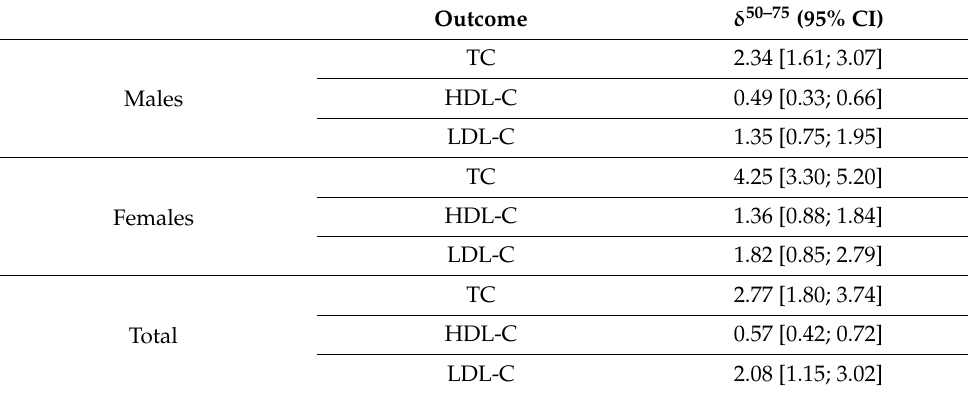
Table 4. BKMR estimates * and 95% confidence intervals for the change in TC, HDL-C and LDL-C, stratified by